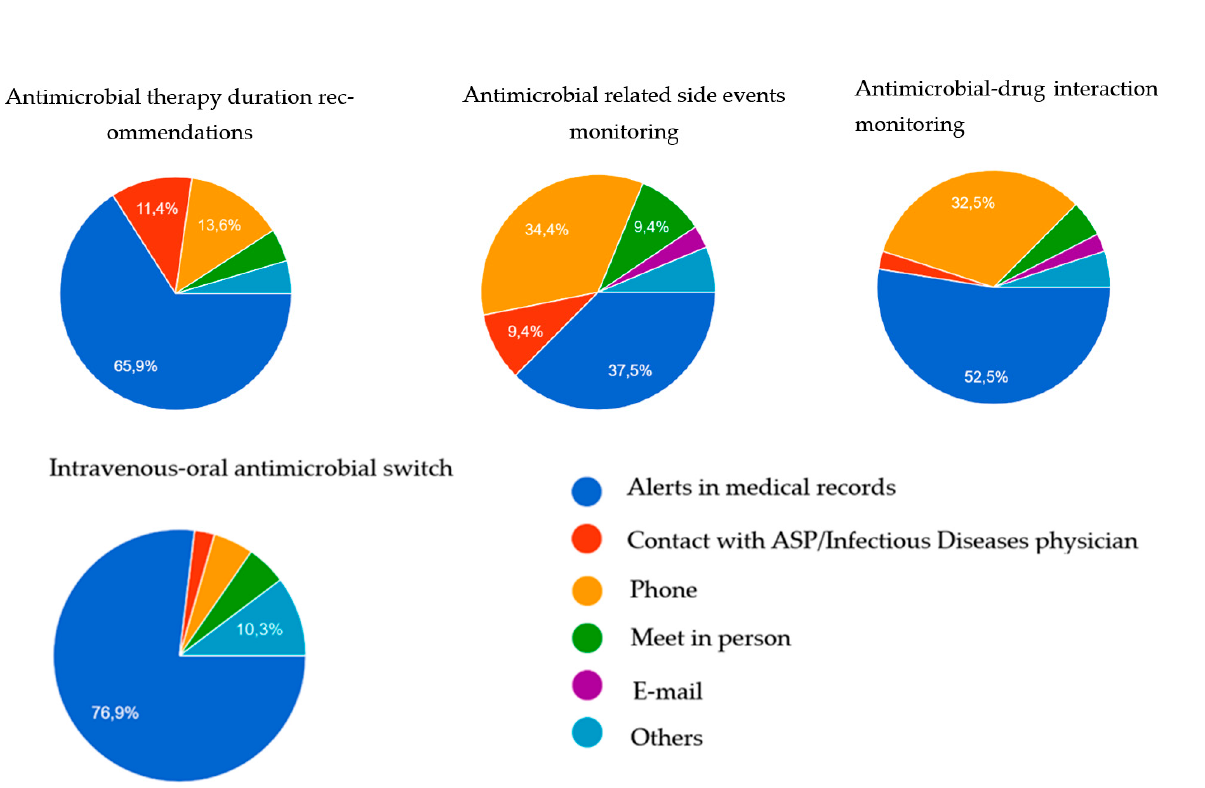
Figure 2. Methods of recommendation delivery of antimicrobial stewardship activities performed by clinical pharmacists.